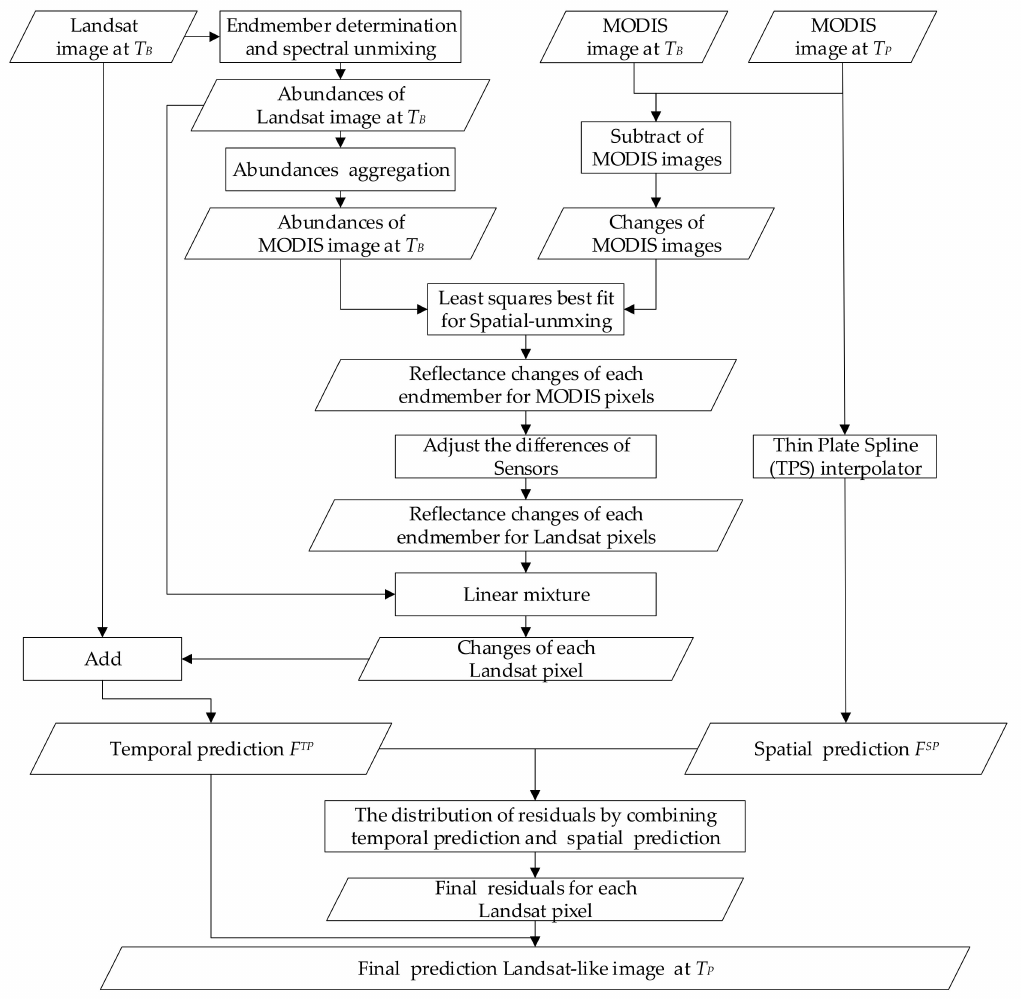
Figure 1. Flowchart of the proposed Enhanced Flexible Spatiotemporal DAta Fusion (EFSDAF)